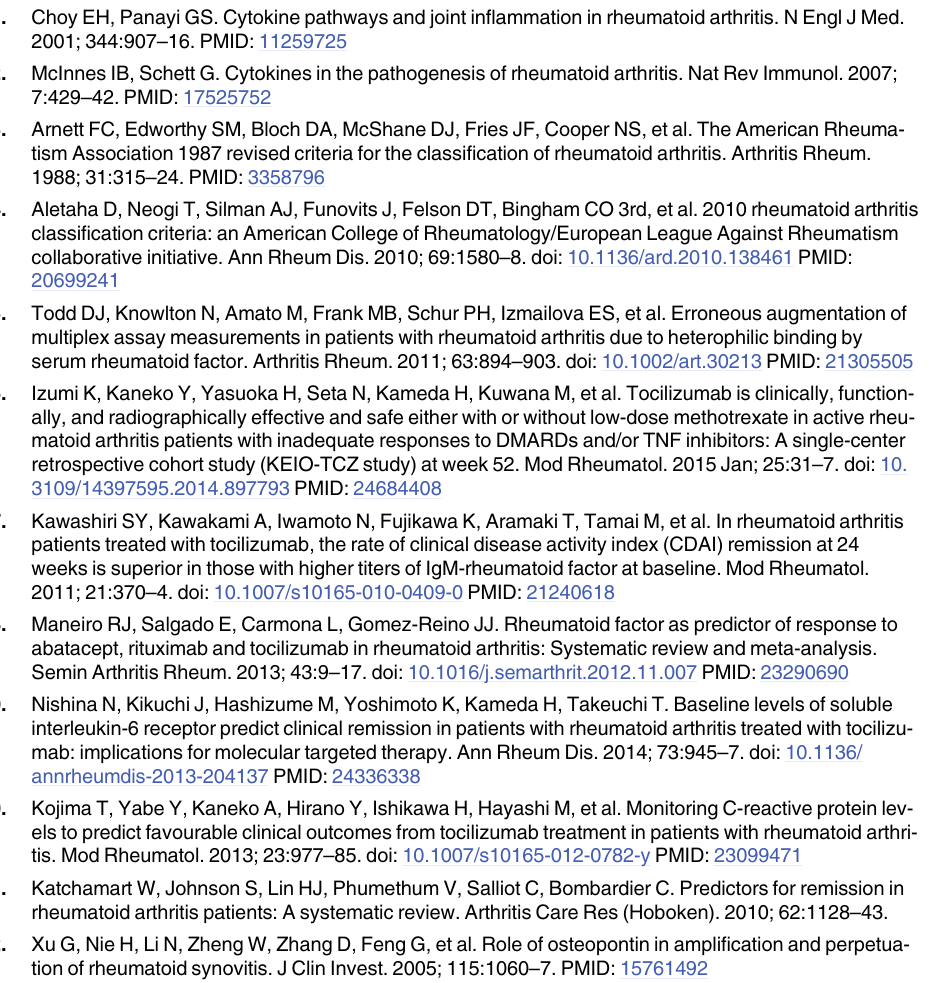
S4 Fig. Predictive ability of OPN for DAS28-ESR remission in patients with RA who received TCZ. S5 Fig. Predictive ability of OPN for CDAI remission in patients with RA who received TCZ with concomitant